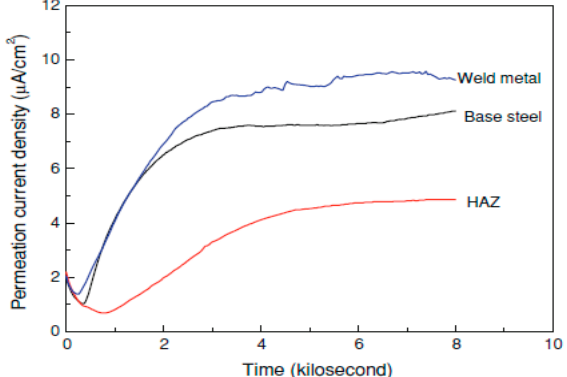
Figure 9. Hydrogen permeation current curves [73].